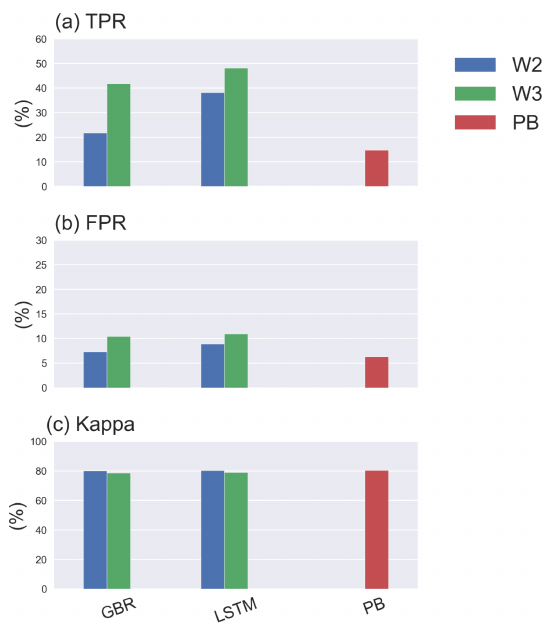
Figure 3. TPR, FPR, and kappa of GBR and LSTM models in work- flow 2, 3, and the PB